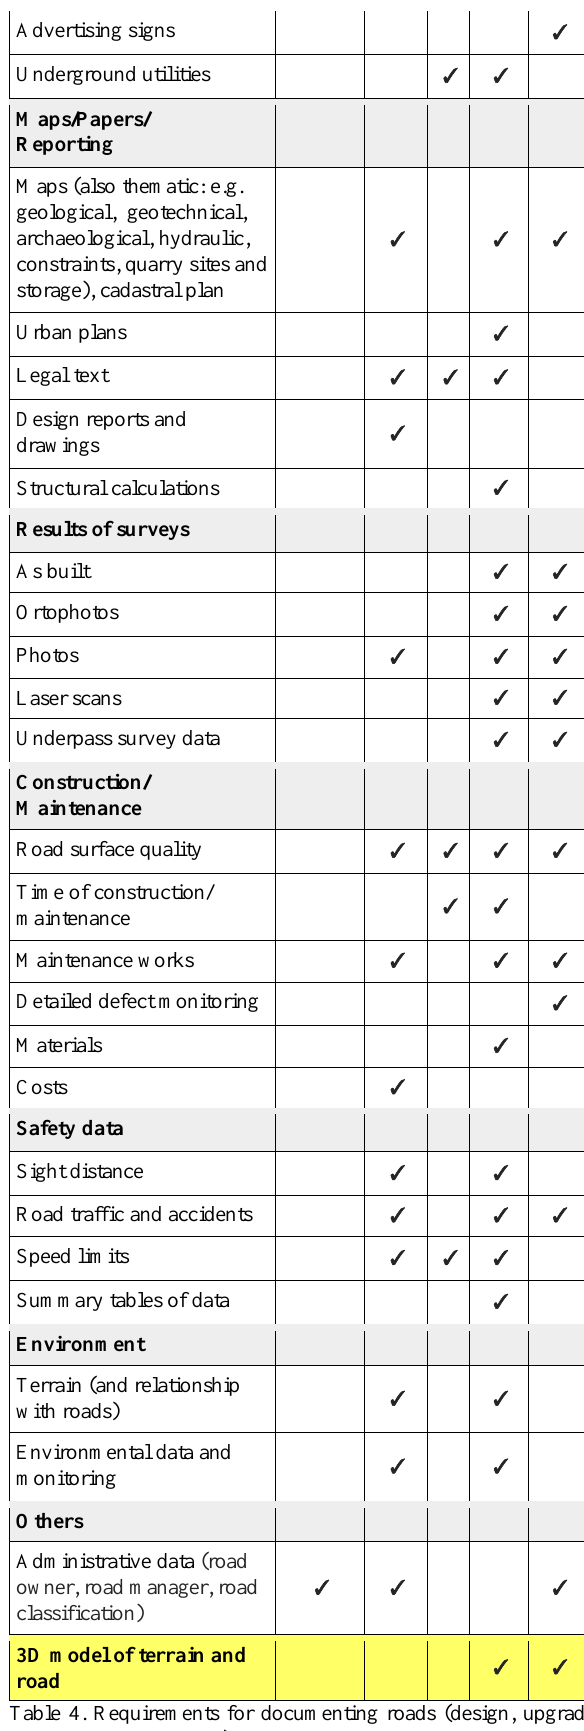
Table 4. Requirements for documenting roads (design,